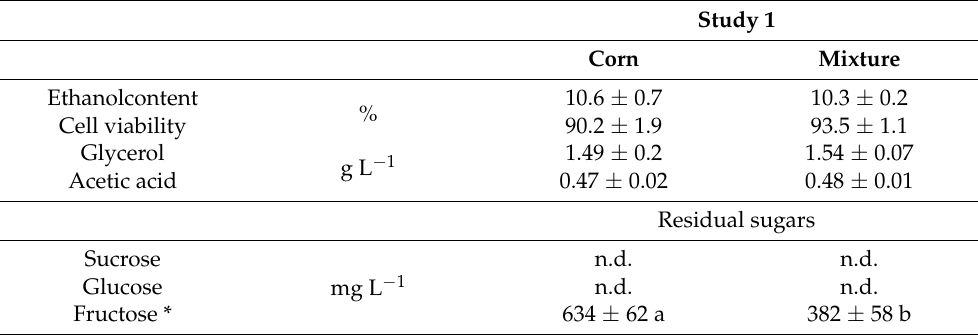
Table 2. Ethanol (vv − 1 ), glycerol (wv − 1 ), and acetic acid (wv − 1 ) contents, yeast cells viability, and residual sugars after 24 h of fermentation obtained in Study 1 using corn and mixture of corn and energy cane as a source of carbohydrates for